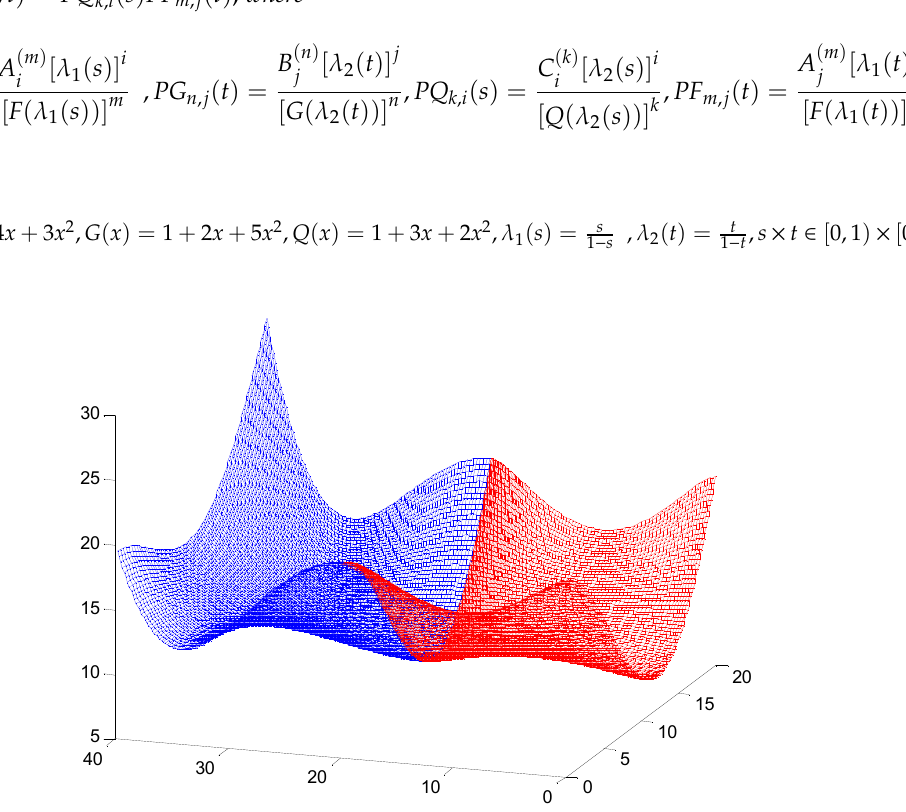
Figure 6. G 1 smooth continuity of two S- λ surfaces in the u and v direction.